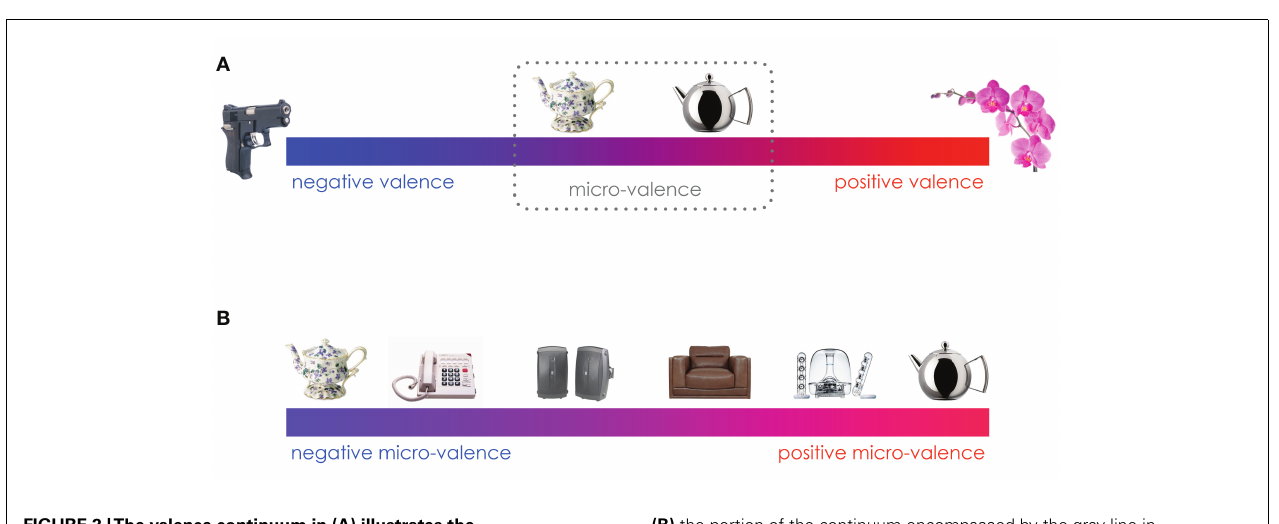
(B) the portion of the continuum encompassed by the gray line in (A) has been expanded to represent a finer-grained continuum.The ordering of objects here reflects this expanded continuum, albeit with lesser magnitudes (the ordering of objects in this figure is derived from Lebrecht andTarr,